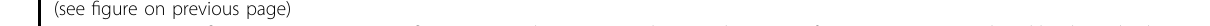
Fig. 3 CircPSMA1 functions as a sponge of miR-637. A The 10 potential targeted miRNAs of circPSMA1 were predicted by three databases. The green circle means circPSMA1 and red rectangle indicates the targeted miRNAs. The image shows the binding sites of circRNA-miRNAs. B The signaling pathways of the 10 miRNAs were analyzed by DIANA-miRPath v3.0 (http://snf-515788.vm.okeanos.grnet.gr/). C The expression levels of these candidate miRNAs after cotransfected with luc-circPSMA1 (plasmid that overexpressed circPSMA1 and labeled with luciferase) or luc-circ-NC (plasmid that overexpressed circ-NC and labeled with luciferase) with candidate miRNA mimics. D Schematic illustration of circPSMA1-WT and circPSMA1-Mut luciferase reporter vectors and the miR-637 binding site on circPSMA1 predicted by miRanda. E The dual-luciferase reporter assay was carried out to validate whether miR-637 could directly bind to circPSMA1. After cotransfected circPSMA1-WT or circPSMA1-Mut luciferase reporter vectors with miR-637 mimic or NC respectively, the relative luciferase activities were detected by spectramax. F , G The qRT-PCR analysis detected the relative expression of miR-637 after overexpression or knockdown of circPSMA1. H FISH assay displayed the cellular location of circPSMA1 (red) and miR-637 (green) in MDA-MB-231 cells (magni fi cation, ×200, scale bar, 50 μ m). I , L EdU assays showed the percentage of EdU-positive cells in BT-549 and MDA-MB-231 cells after overexpression or knockdown of miR-637 by mimic and inhibitor (magni fi cation, ×100, Scale bar, 100 μ m). M – O Transwell assays detected the migration abilities of TNBC cells after overexpression or knockdown of miR-637 by transfected with miR-637 mimic, miR-637 inhibitor or their NC (mimic-NC and inhibitor-NC) (magni fi cation, ×100, Scale bar, 100 μ m). Data were shown as mean ± SD at least three independent experiments, * p < 0.05, ** p <